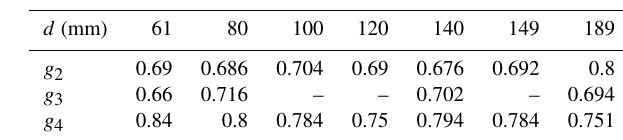
Table 7. Measured wave period T (s) for test cases d = 61 and 120 (Figs. 7 and 8) and d = 80 , 100 , 140 , 149, and 189 (Fig. 9).